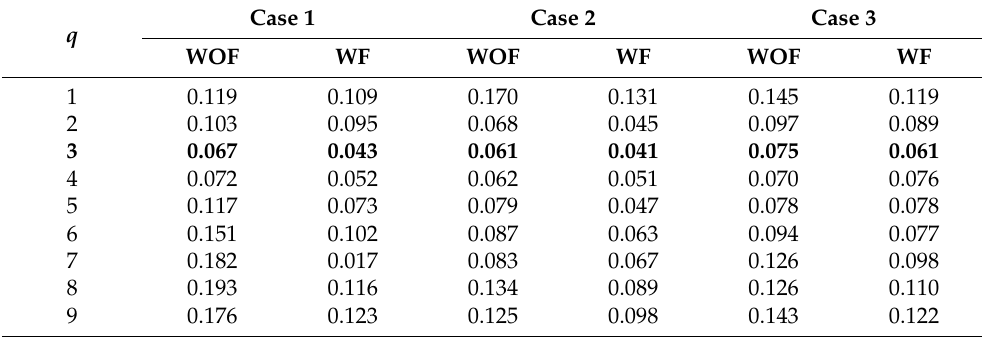
Table 4. The RMSE of the ANFIS-BFDM in the three data cases (see Table 2) depends on q (16) (WF: with the FIN; WOF: without the FIN; the bold: the results when q = q opt = 3).